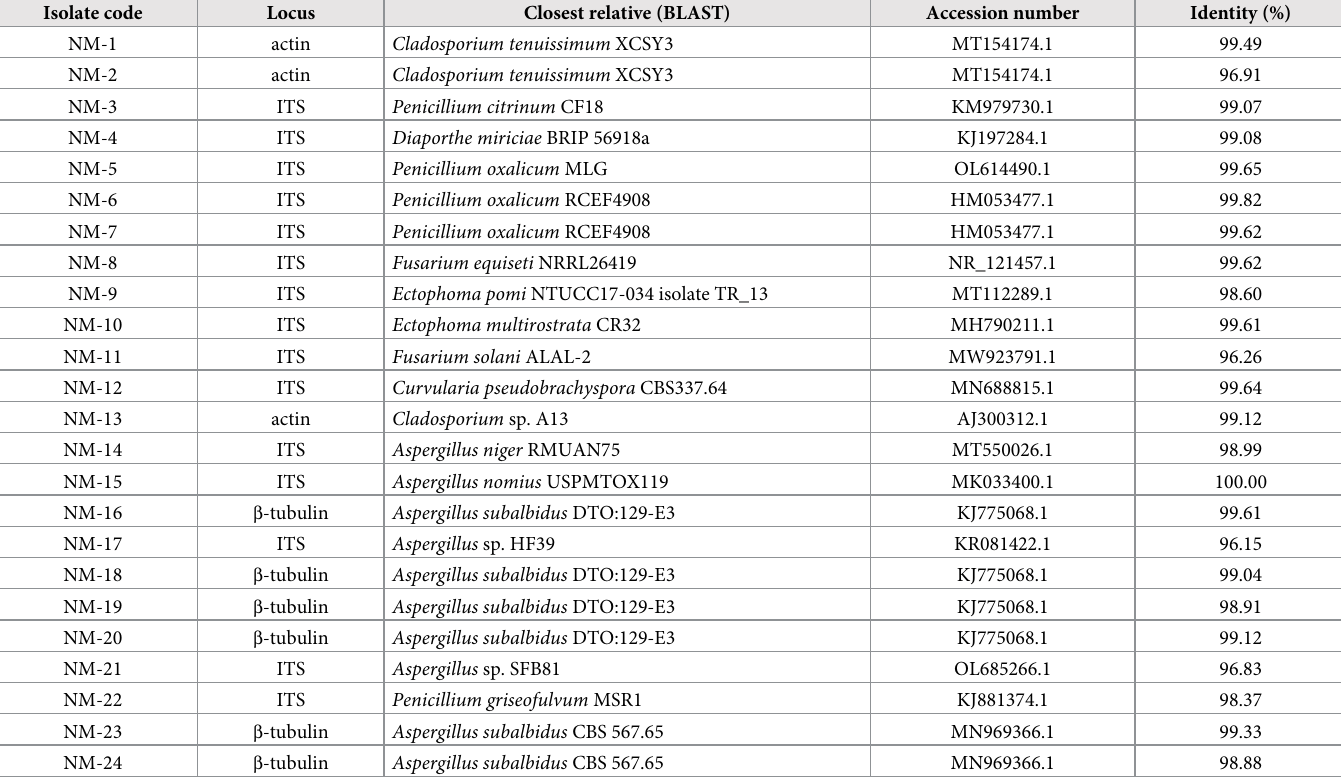
Table 2. BLAST analysis results of the fungal isolates from solar salterns in Pattani Province and their close relatives. Isolate